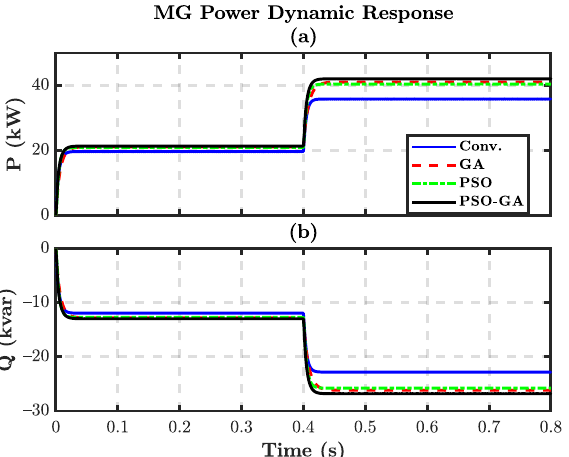
Figure 17. Active and reactive power of the MG under linear load changes for different designed parameters: ( a ) active power; ( b ) reactive power.